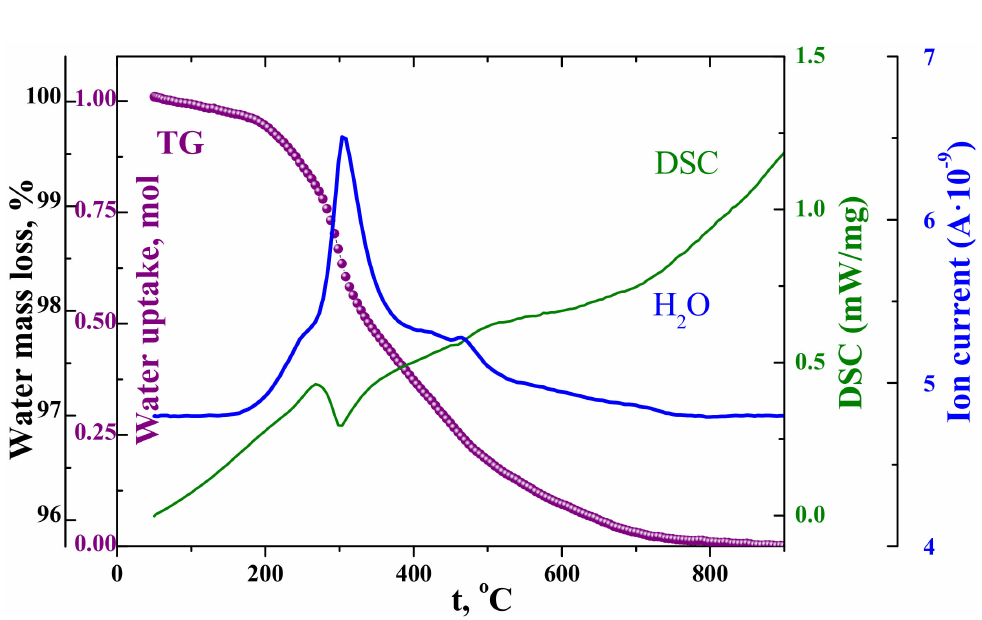
Figure 2. The TG, DSC and MS results for the composition BaLa 0.9 Pr 0.1 InO 4